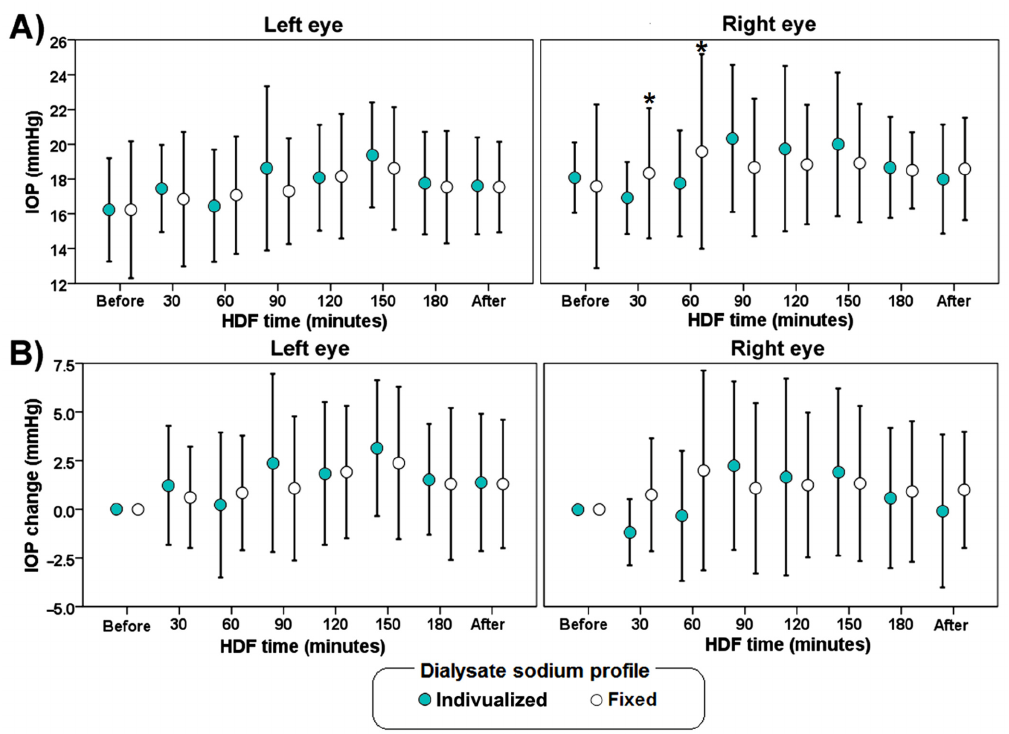
Figure 3. Average values of IOP ( A ) and IOP change ( B ) during hemodiafiltration (HDF) with different dialysate sodium profile (individualized or fixed at 138 mmol/L). The error bars indicate one standard deviation. The asterisk (*) indicates a significant difference ( p < 0.05) versus measurements in the left eye. Although, there was no difference in blood pressure, there was a decrease in heart rate at 30, 60, 90, 120, and 150 min in the fixed sodium profile HDF group compared with its own baseline at the beginning of HDF (Figure 4).